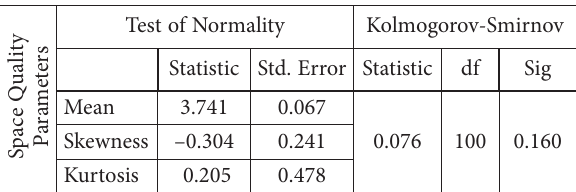
Table 3. Normality results of space quality parameters